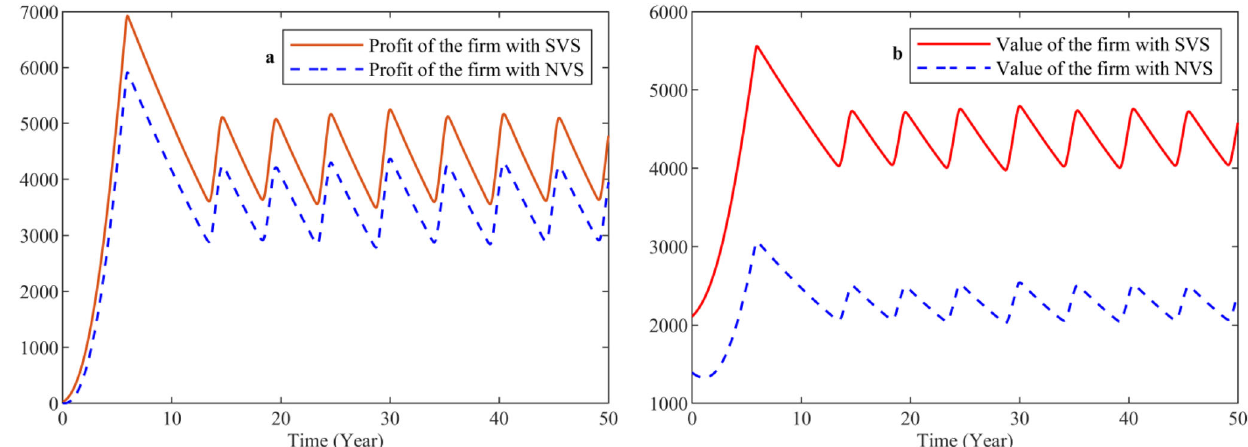
Fig. 5 Evolution of pro fi t and value with SVS and NVS. a Evolution of pro fi t with SVS and NVS. b Evolution of fi rm value with SVS and NVS.